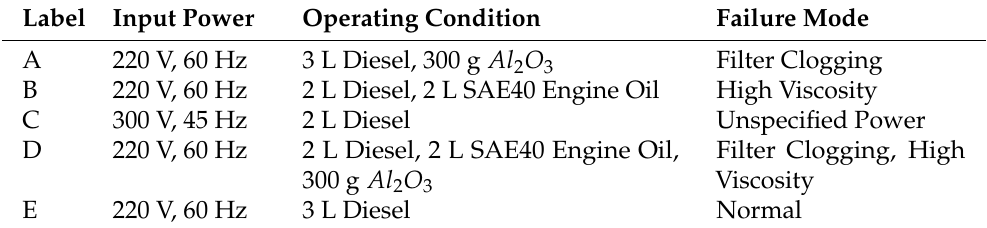
Table 2. Proposed pump operating conditions.